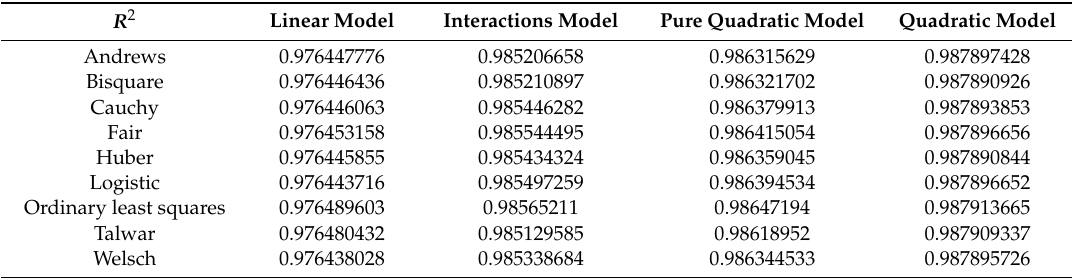
Table 3. The R 2 of the combination of four kinds of model specification parameters and nine kinds of robust weight function parameters.